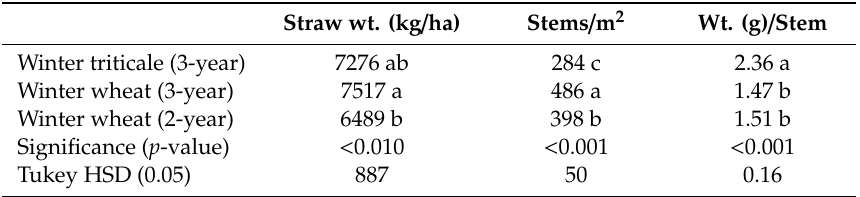
Table 3. Straw dry biomass weight, stem number and stem weight for winter triticale and winter wheat averaged over five years (2015–2019) at Ritzville, WA. Within-column letters followed by a di ff erent letter are significantly di ff erent. HSD = honest significant di ff erence.